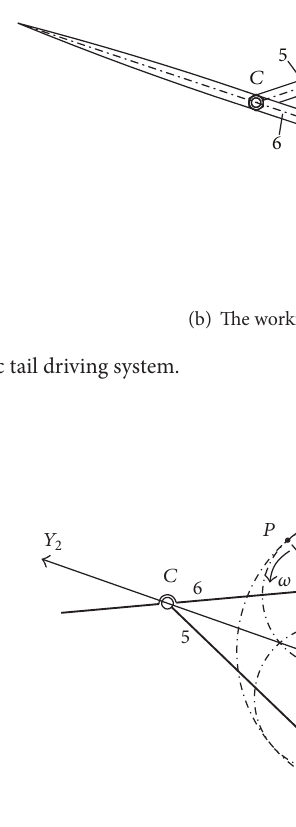
Figure 2: The working principle of the tail driving